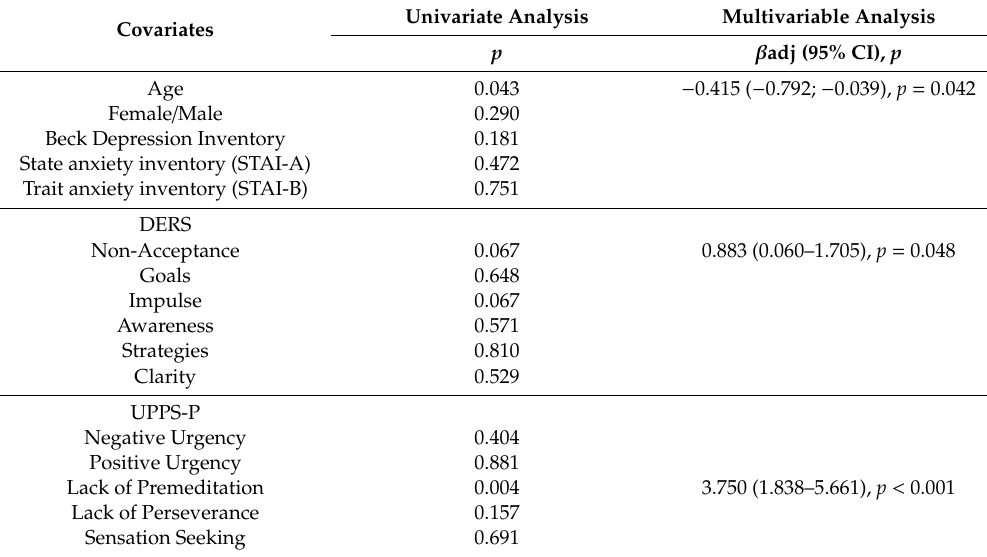
Table 3. Multiple linear regression analysis of the association between DEBQ subscale (Emotional eating) and sociodemographic and clinical characteristics in the BED group.